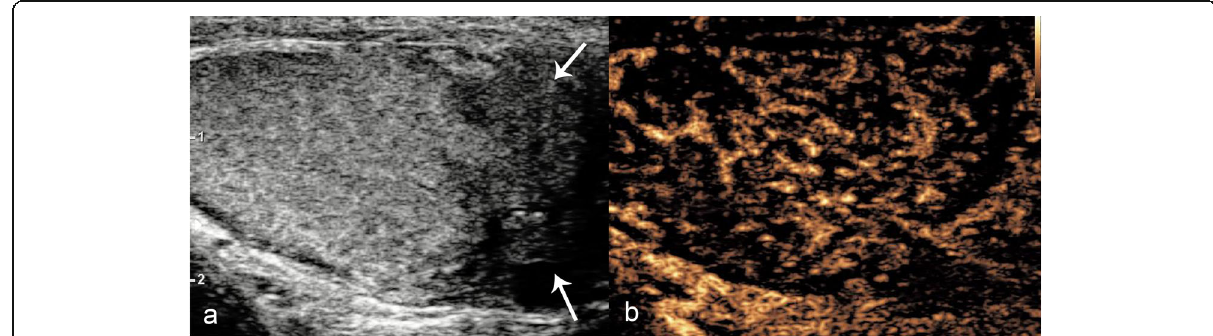
Fig. 4 CEUS excluding ischaemia. B-mode ( a ) image demonstrated a hypoechoic, atrophic and heterogeneous lower pole (arrows) raising